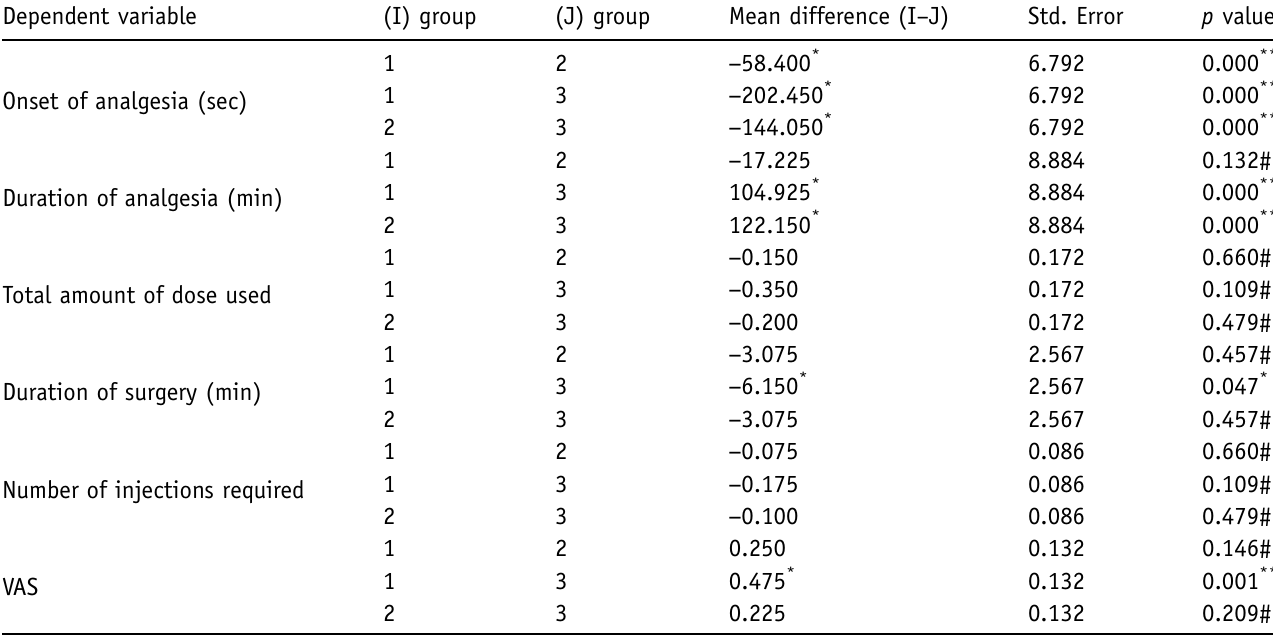
Table II. Inter group pair wise comparison using post hoc tests.